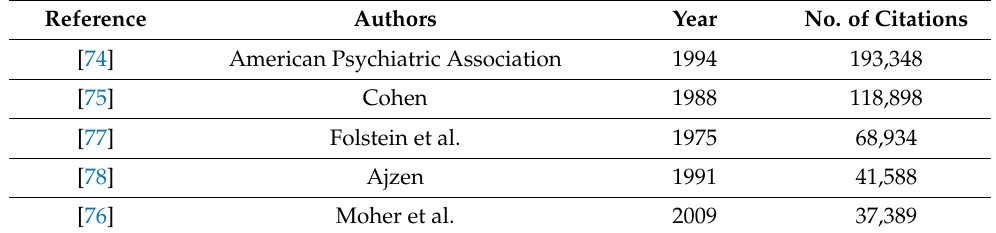
Table 8. Top cited references cited by the analyzed systematic reviews on SSG (up to 23 May 2022).